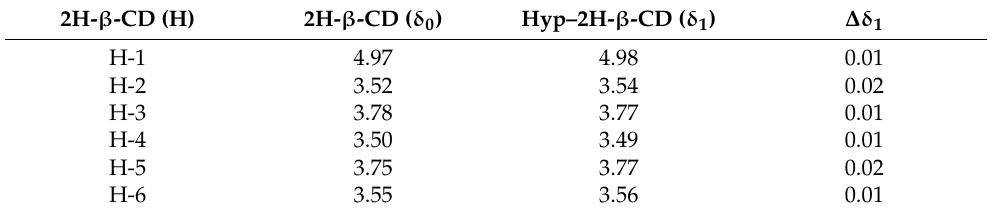
Table 2. 1 H NMR chemical shifts of 2H- β -CD before and after forming IC.